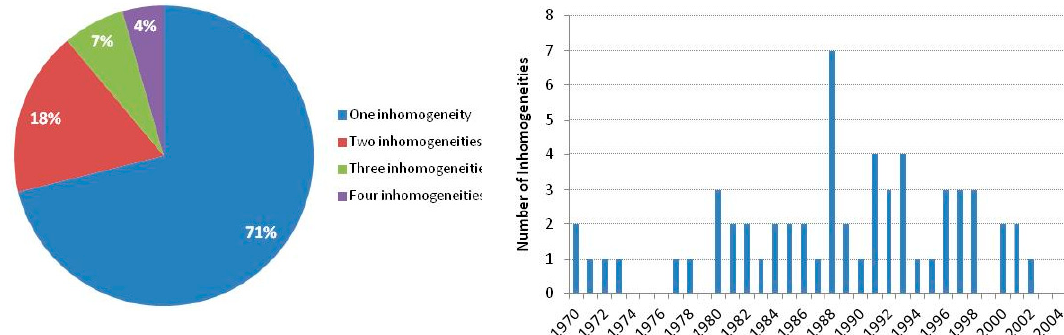
Figure 4. Percentage of detected and corrected inhomogeneities ( Left ); number of inhomogeneities per year ( Right ).